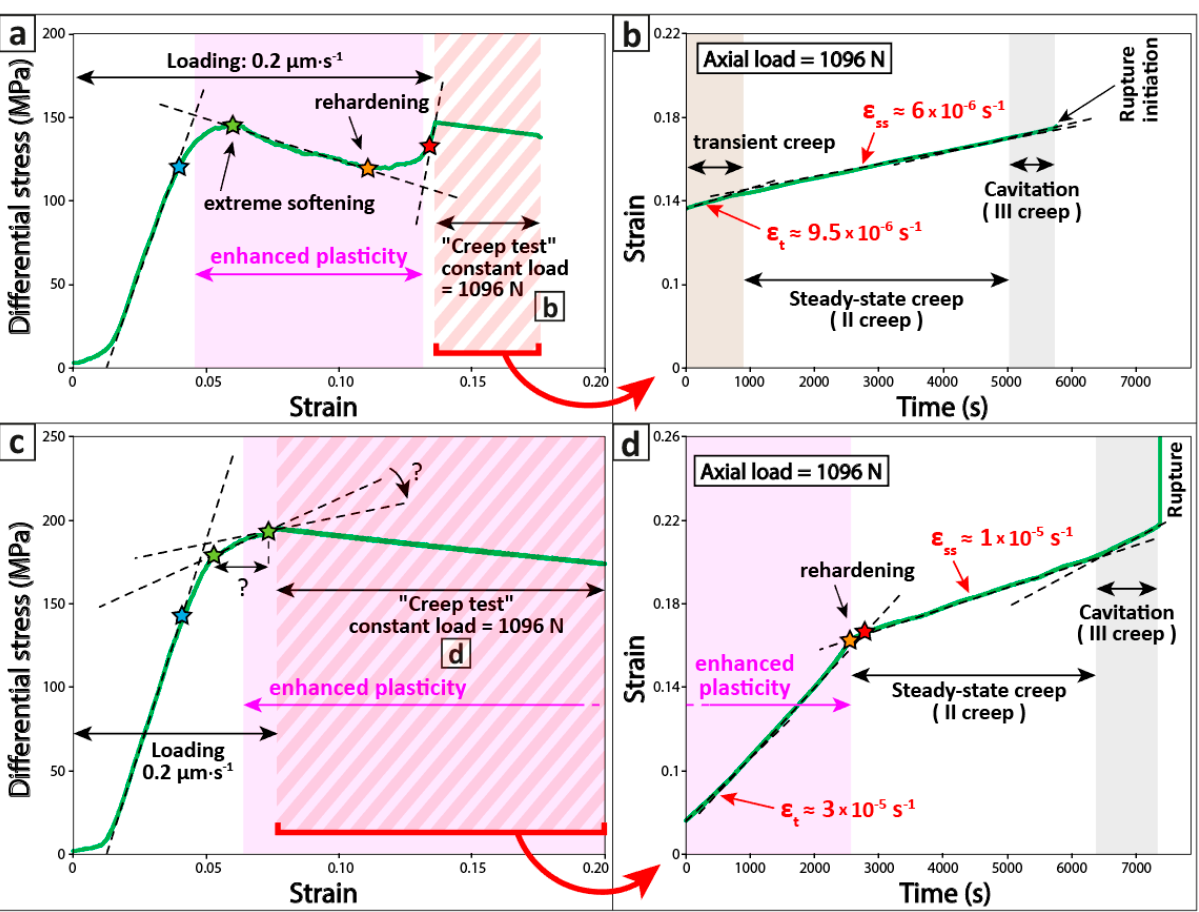
Figure 5. Enhanced plasticity: mechanical data at 1000 ± 7 °C. ( a ) Differential stress as a function of strain for run KG-332 (sample SP-314-2; . ε = 3.17 × 10 − 5 s − 1 ), exhibiting a transient softening during loading; ( b ) Strain as a function of time at a constant load of 1096 N (details in Figure S5); ( c ) Differential stress as a function of strain for run KG-342 (sample SP-322-2; . ε = 3.17 × 10 − 5 s − 1 ); ( d ) Strain as a function of time at a constant load of 1096 N, showing rehardening after ≈ 40 min of creep. The stars account for the four critical stress values marking the onset of plasticity (blue), the beginning of the linear softening stage (light green), the onset of rehardening (orange) and the beginning of the linear response of the final material (red). Note that the position of the green star in ( c ) is uncertain because of the proximity with the load target and that the orange and red stars are indicated on ( d ). For detailed information, see Section 4.